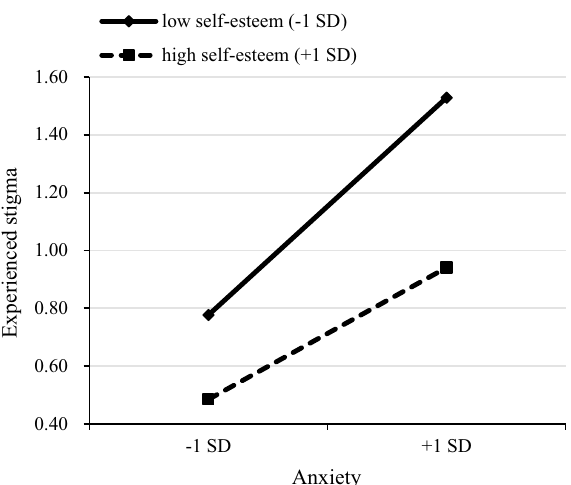
Figure 1. Simple slope plot of interaction between experienced stigma and self-esteem on anxiety. SD standard deviations.